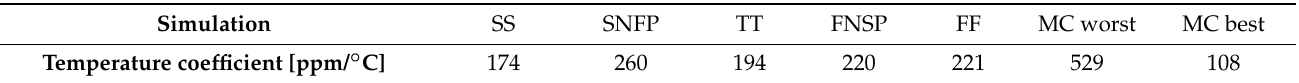
Figure 5. Monte Carlo simulations of PCS output current. Table 3. Simulation-based temperature coefficients of PCS.